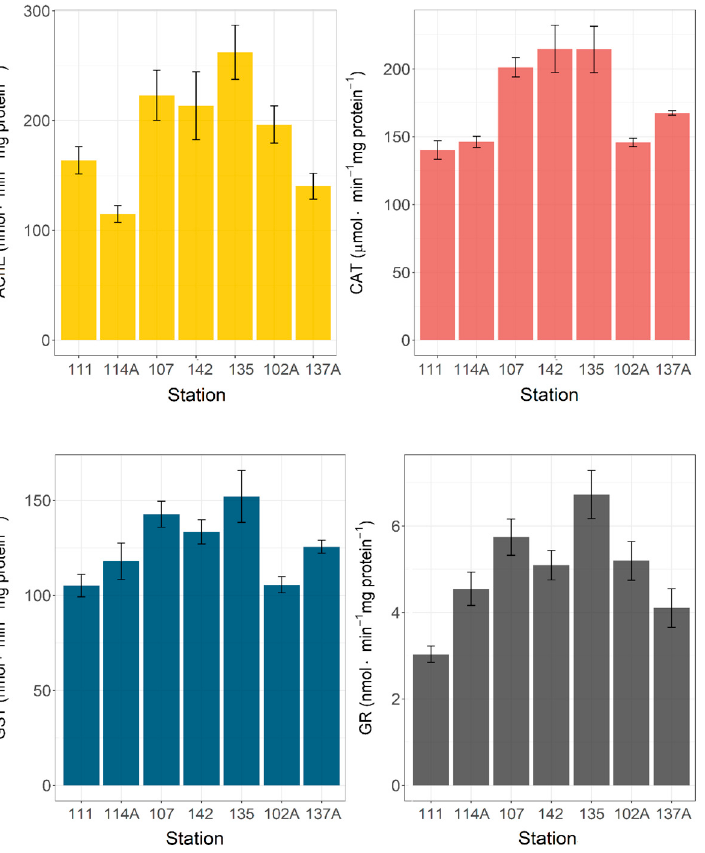
Figure 3. Activity (mean ± SE) of AChE, CAT, GST, and GR in M. affinis at the deep-water stations in November 2021.